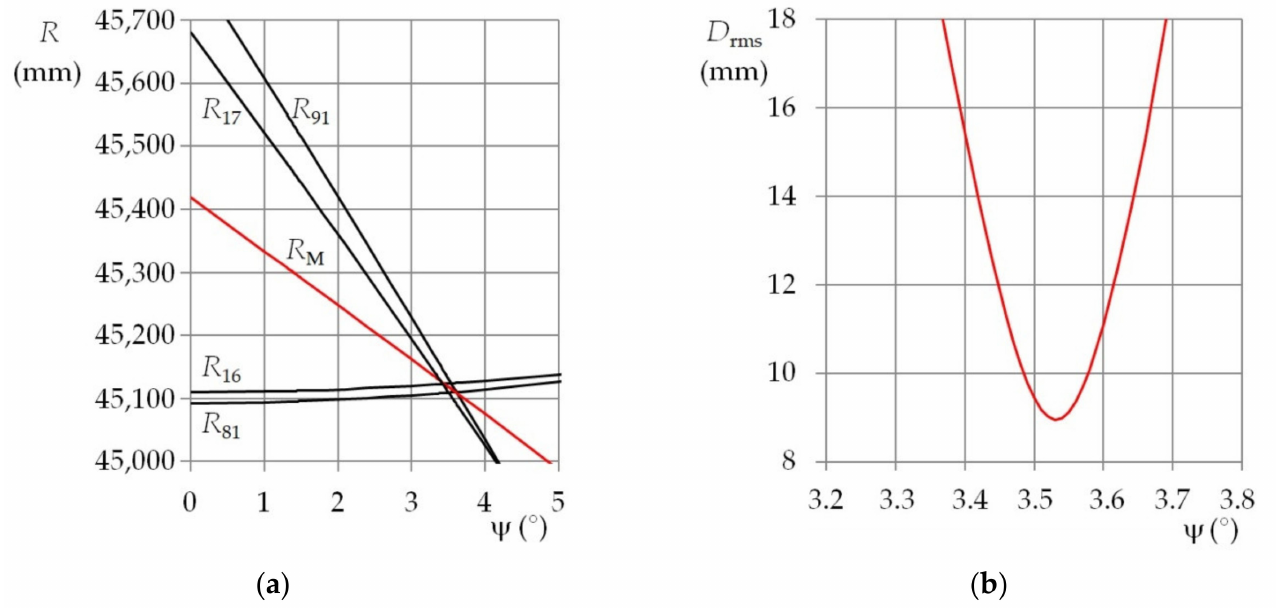
Figure 7. ( a ) Plots of the functional distances for diodes S 6 , S 7 , S 8 , and S 9 ; ( b ) root mean square of the distance deviations for diodes S 6 , S 7 , S 8 , and S 9 ; R 0 = 46,820 mm, f L = 120 mm, ω n = ψ n = 0 ◦